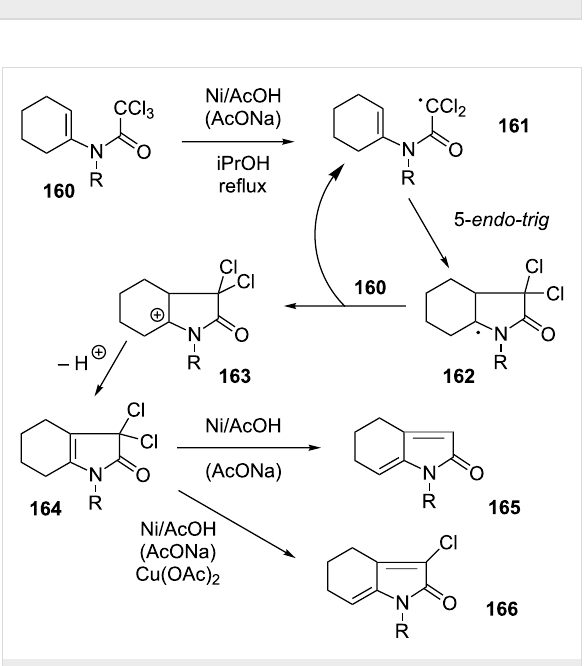
Scheme 30: Nickel-mediated synthesis of unsaturated